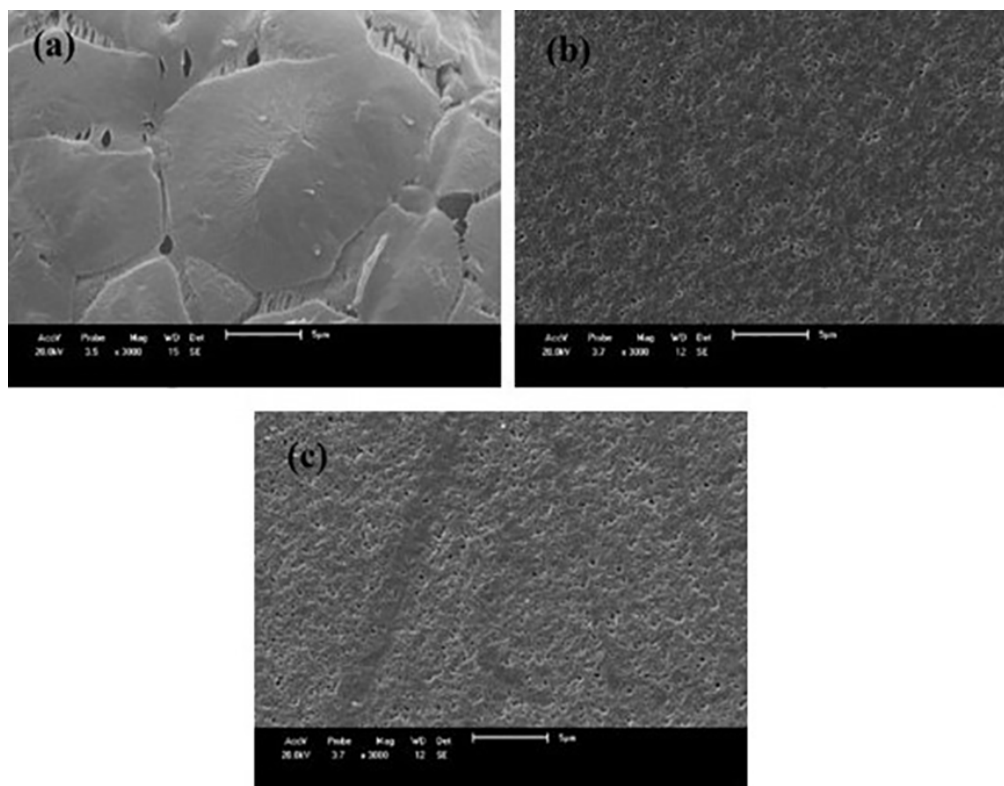
Figure 4. SEM images of the membranes surface of: (a) PA6; (b) PA6 + 3% MMT; and (c) PA6 + 5% MMT